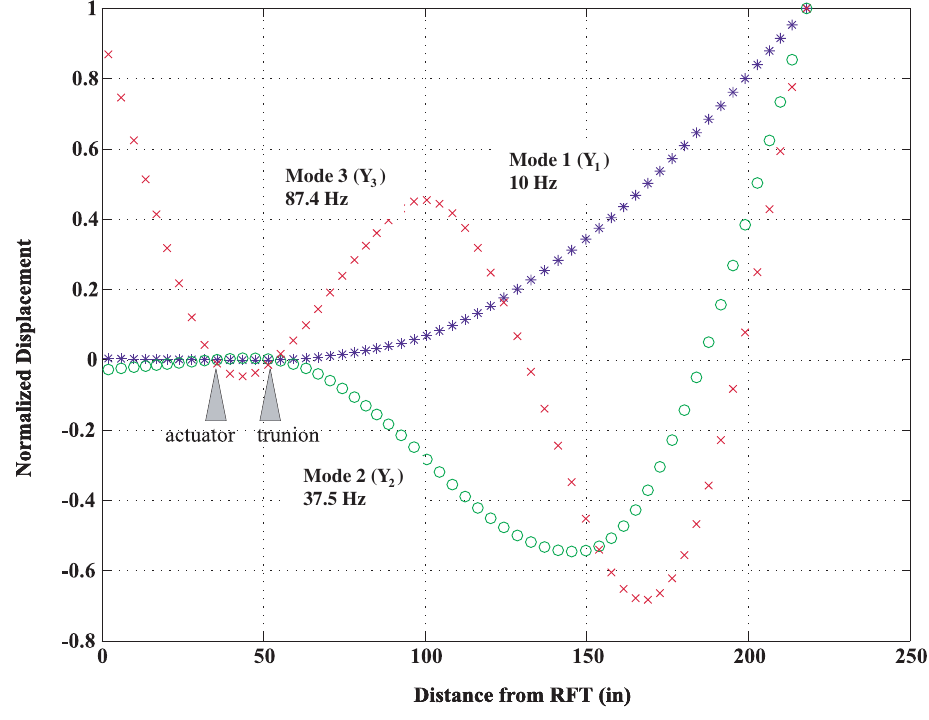
Fig. 3. First three fundamental barrel flexing mode shapes (normalized to unity) for the M256 120-mm